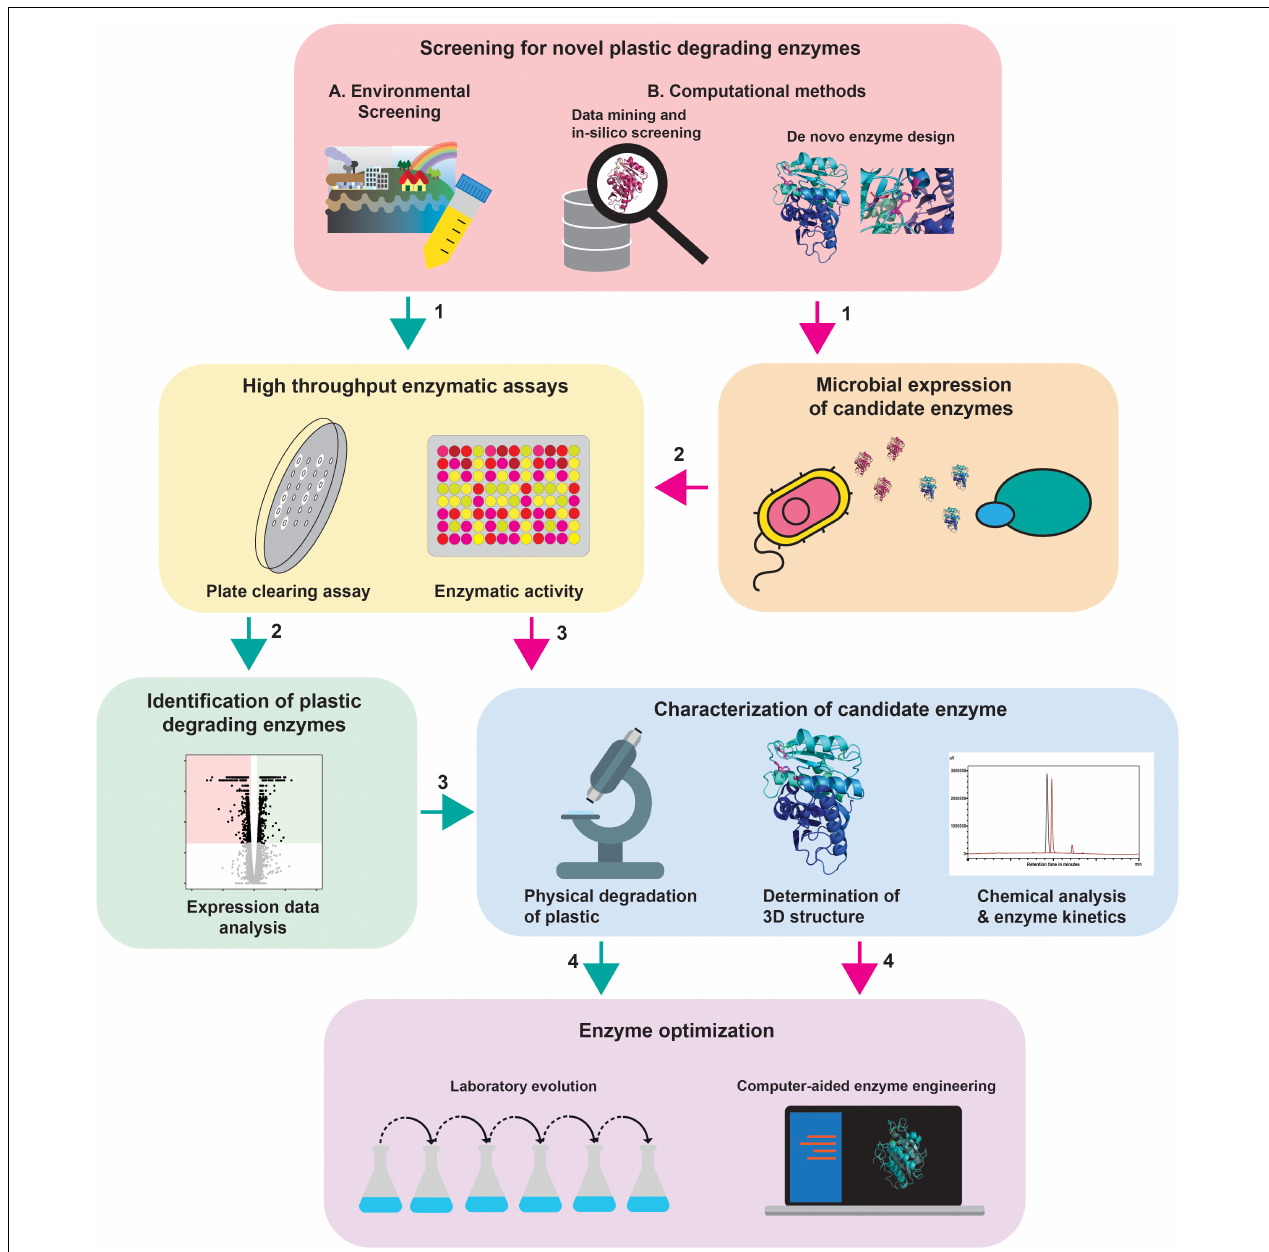
FIGURE 2 | Comprehensive workflow for the identification of plastic degrading enzymes. New plastic degrading enzymes can be found by (A) environmental screening of interesting strains (green arrows) and (B) the computational methods (magenta arrows). In the case of computational methods, the enzymes need to be expressed in a suitable expression system (2) before high throughput enzyme assays can be performed. Via high throughput enzymatic assays, active strains/enzymes can be pinpointed. For the strains isolated via environmental screening, the specific enzymes need to be identified (2). The enzymes can then be further characterized to identify potential targets for enzyme optimization approaches. The protein depicted in this figure is based on PDB ID 6ANE (Fecker et al.,